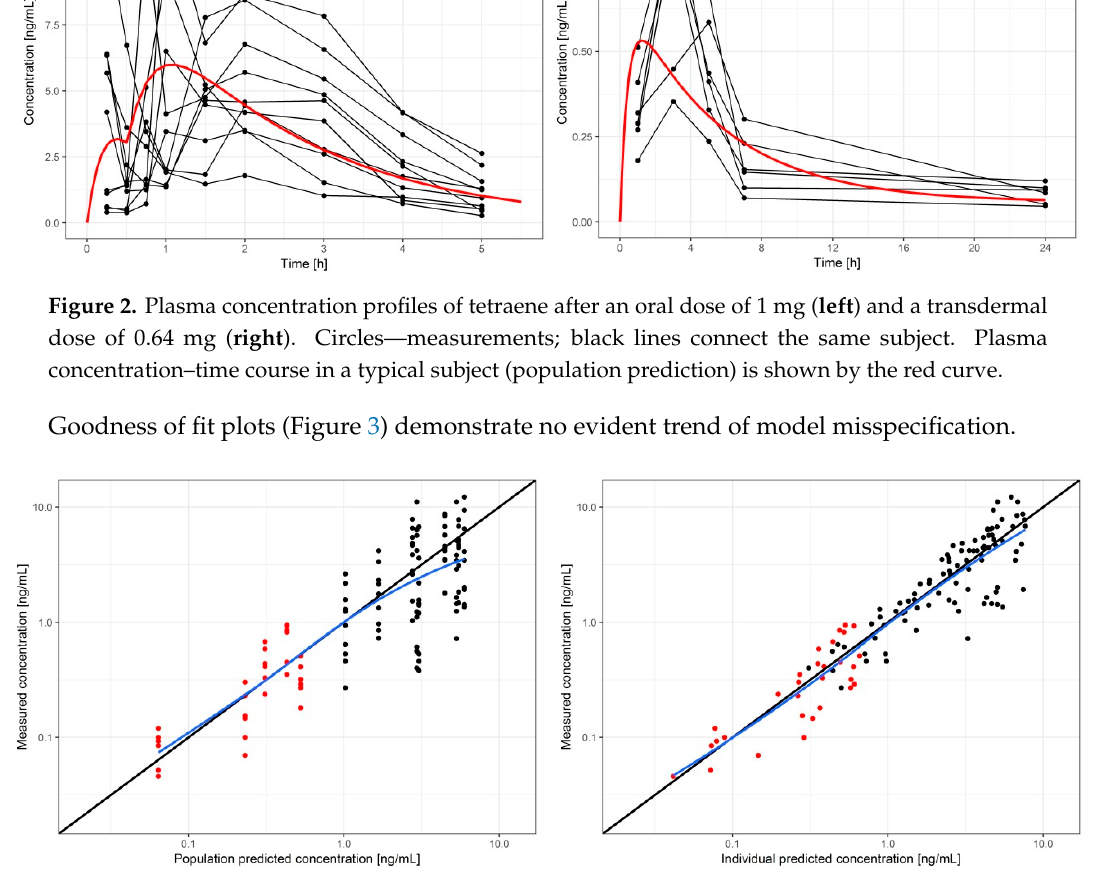
Figure 3. Goodness of fit plots of the final pharmacokinetic model of tetraene. Circles—measured versus population predicted concentration ( left ) and measured versus individual predicted concentration ( right ) after transdermal (red) and oral (black) administration. Black line—identity line; blue line—loess fit.